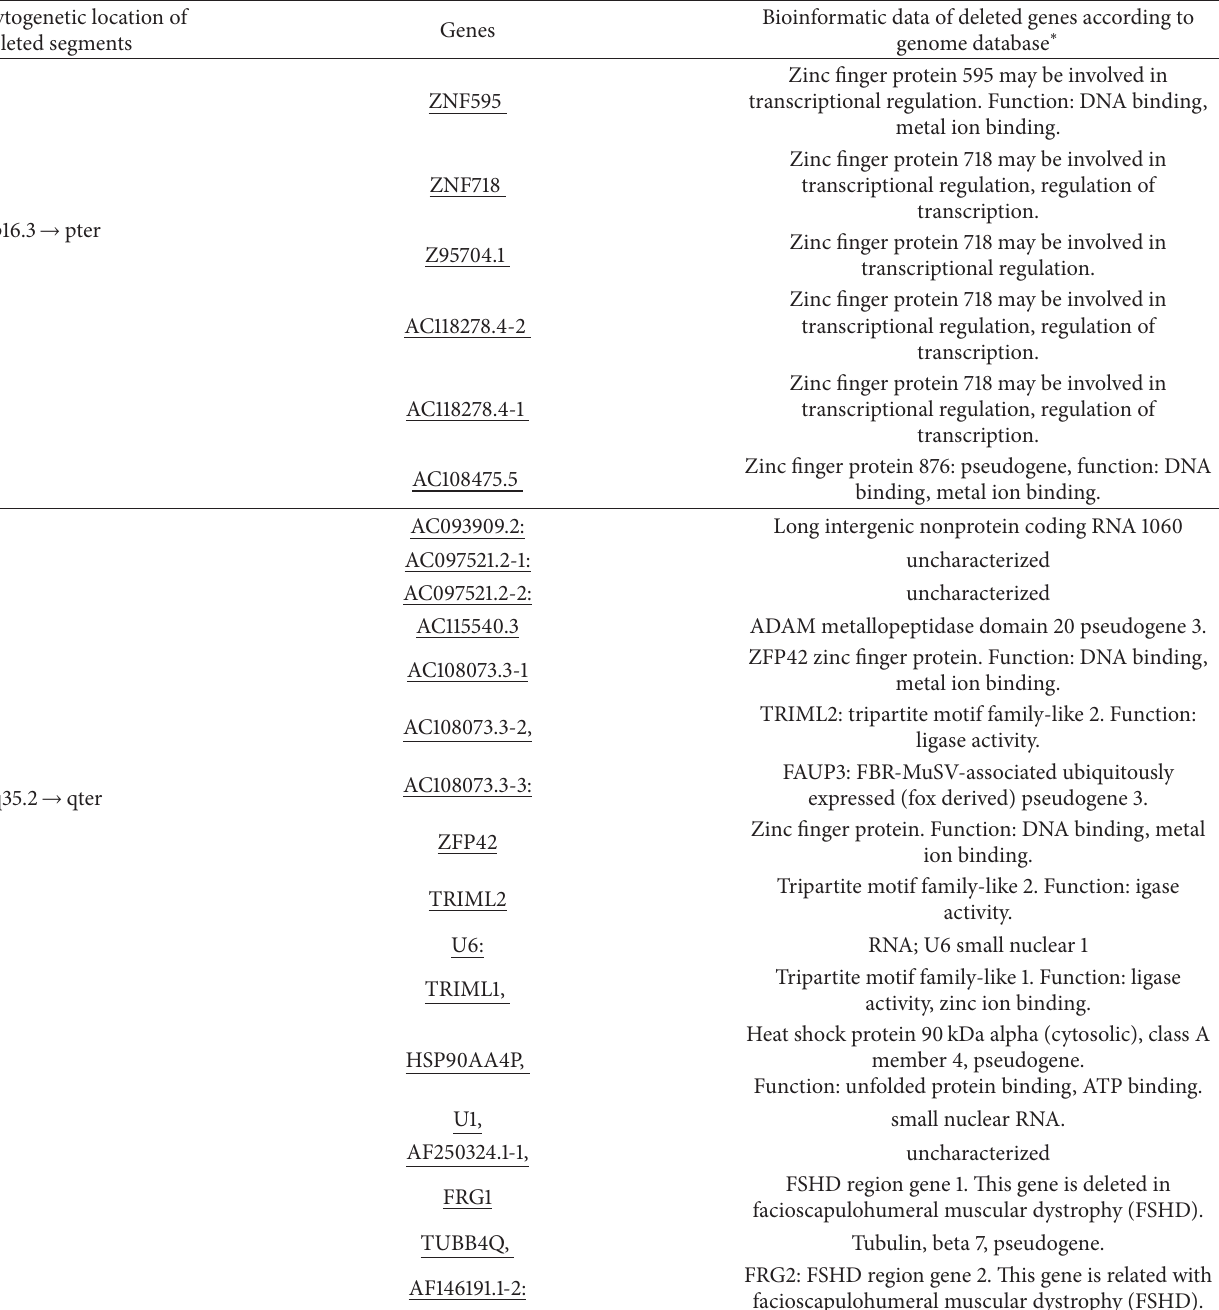
Table 1: Deletions and related genes of ring chromosome by